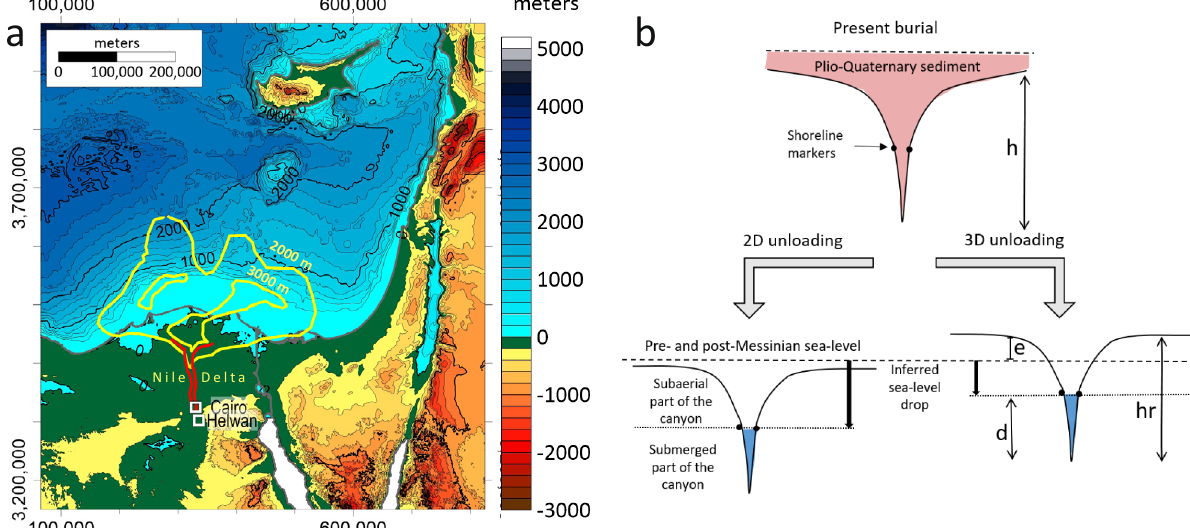
Fig. 1 The expected in fl uence of the Nile delta load on the adjacent Messinian canyon. a Present-day topography and bathymetry. Red line outlines buried canyon walls 23 . Yellow lines are the 2000 and 3000 m 50 thickness contour of the Pliocene-Quaternary section showing that the main sedimentary load is located north of the canyon. b Schematic illustration of the difference between 2D and 3D restoration of the original vertical position of the Messinian canyon. Upper panel shows the present day buried canyon under Pliocene-Quaternary rocks. Left panel illustrates that in 2D analysis, canyon remains fully below present day sea level. Right panel illustrates that 3D analysis, considering the off plane load, is expected to provide higher canyon shoulders. h - the height difference between canyon thalweg and shoulders. hr - the same after sediment unloading (hr < h). e - elevation of canyon shoulders asl. d - water depth in the submerged part of the canyon. The inferred sea level drop is Δ sea level = hr − e −